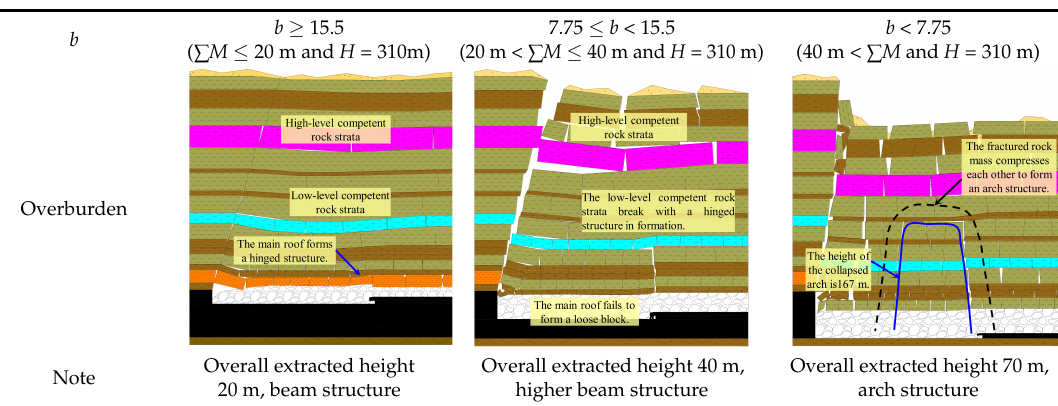
Table 2. Overburden strata pattern for different overall mining